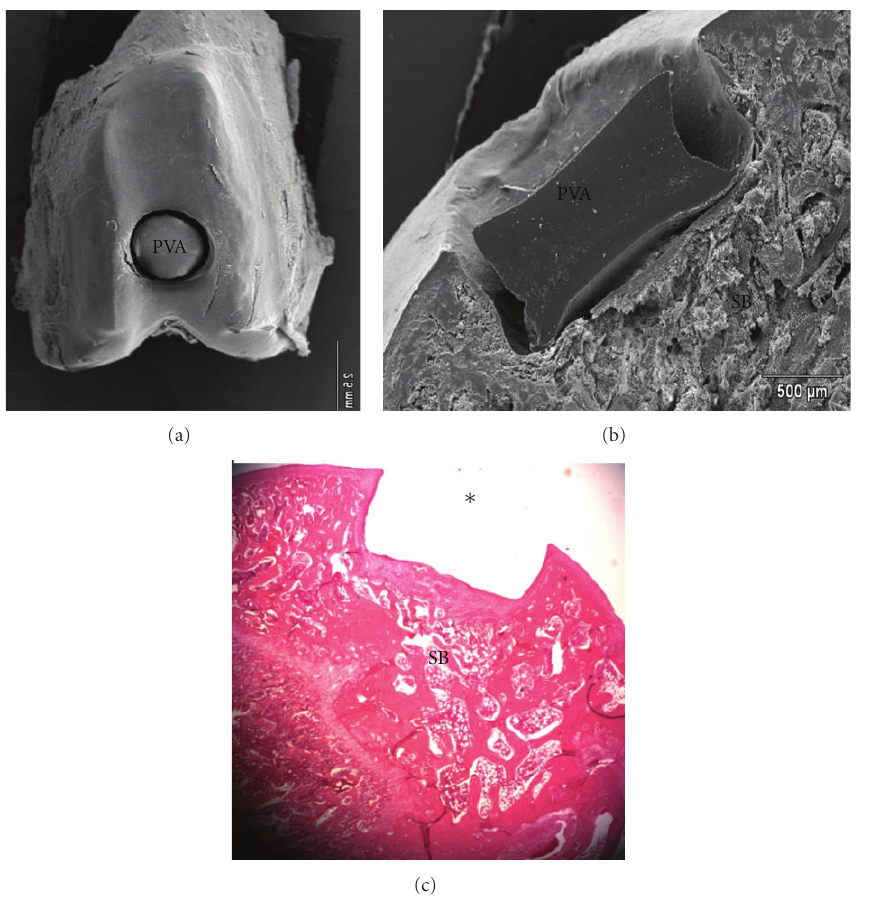
Figure 7: Scanning electron microscopy of the PVA surface in the condyle. (a) Scanning electron microscopy of the PVA interface of the osteochodral defect. (b) Histological section of the condyle- ∗ observe absence of PVA which was removed during the treating process for histological analyses. (c) HE Staining 25x.